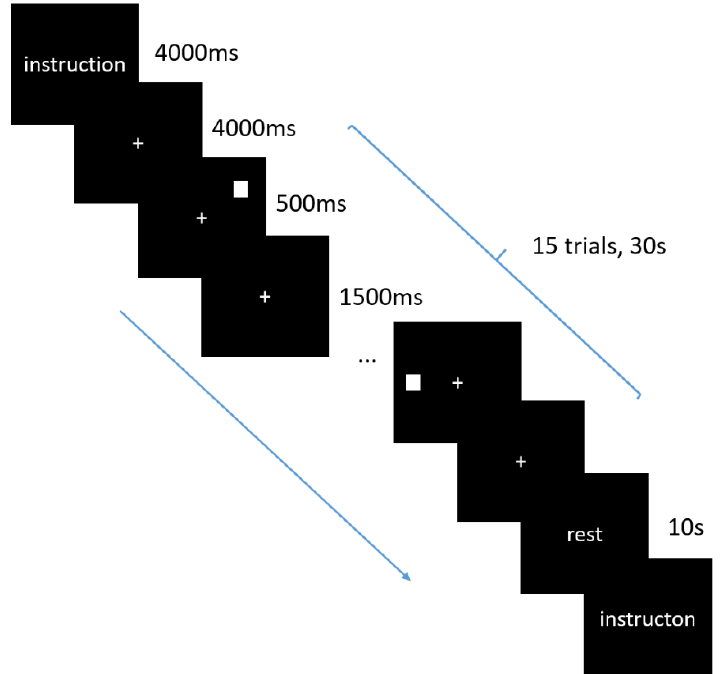
Figure 1. Schematic illustration of the N-back working memory task. The central crosses are the points of fixation and the white squares are the target stimulus. The arrow indicates the order of stimulus presentation.